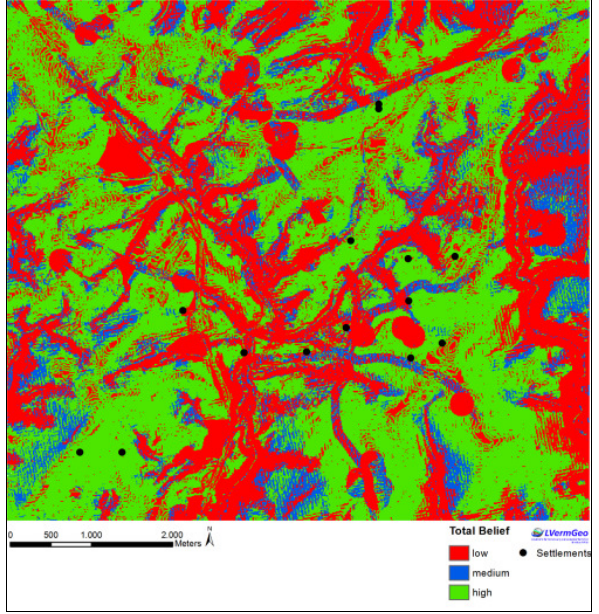
Figure 5. Total Belief of the hypothesis „Presence of site“ after incorporation of the factor ‘wind